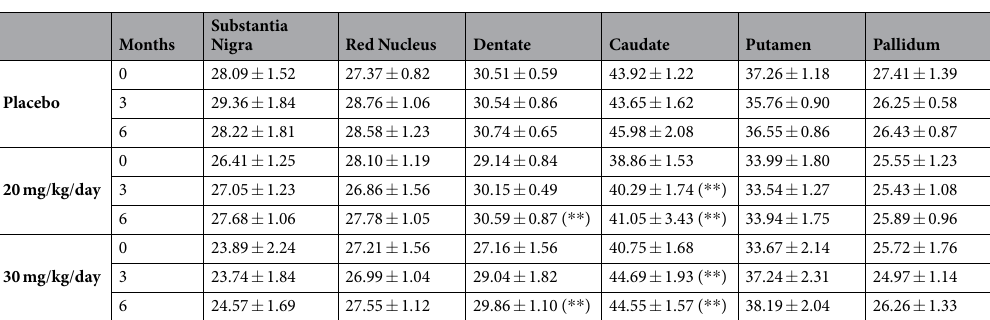
Table 2. Mean T2 * values of six brain region in PD patients analysed at 0, 3 and 6 months after administration of either 20 mg/kg/day or 30 mg/kg/day deferiprone or receiving placebo. Results are presented as mean ± standard error. ** p <